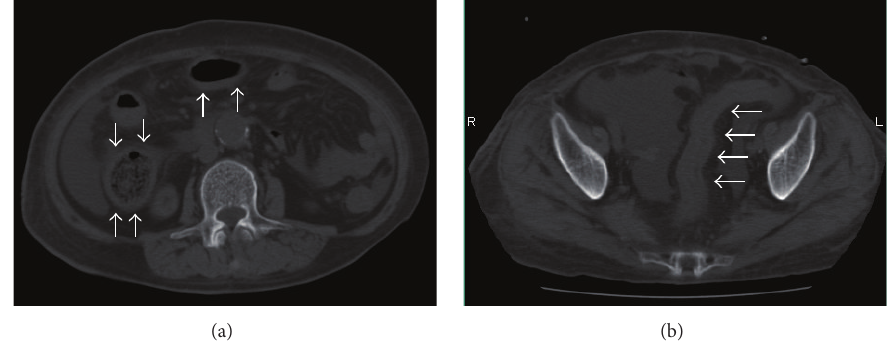
Figure 1: Computed tomography before treatment. Diffuse wall thickness of (a) the ascending colon and transverse colon and (b) the sigmoid colon (white arrows).